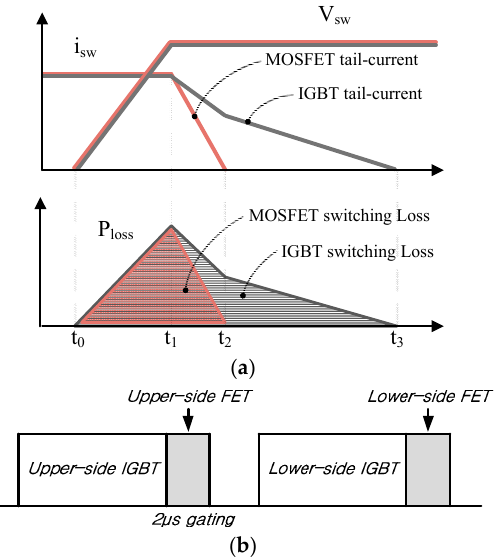
Figure 7. Tail current in turn ‐ off and hybrid switching: ( a ) turn ‐ off tail current; ( b ) hybrid switching.